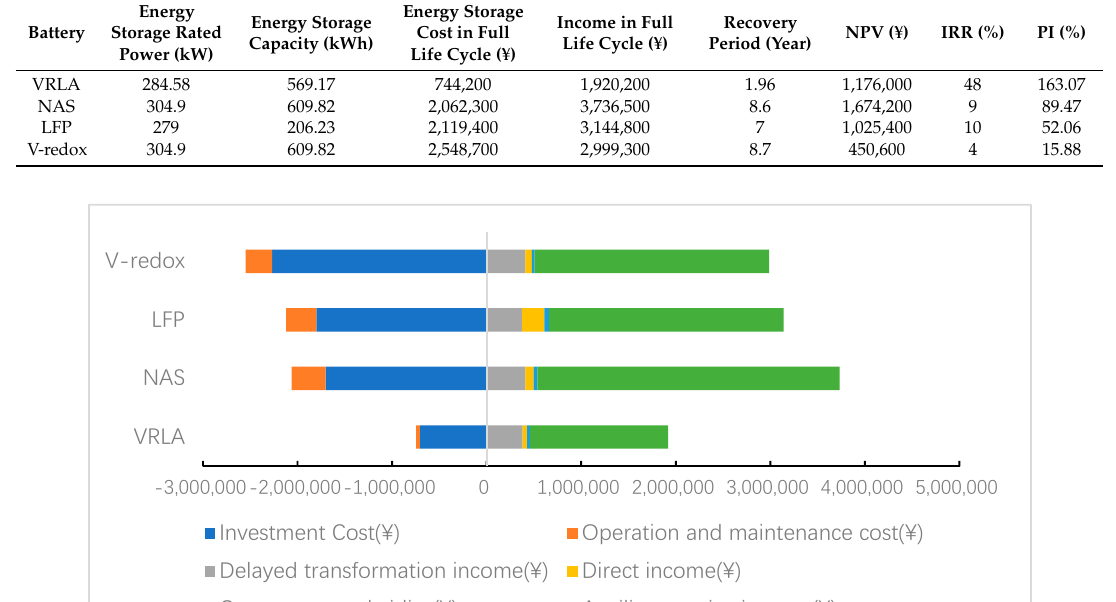
Table 6. Energy storage configuration and economic evaluation results of demand response.